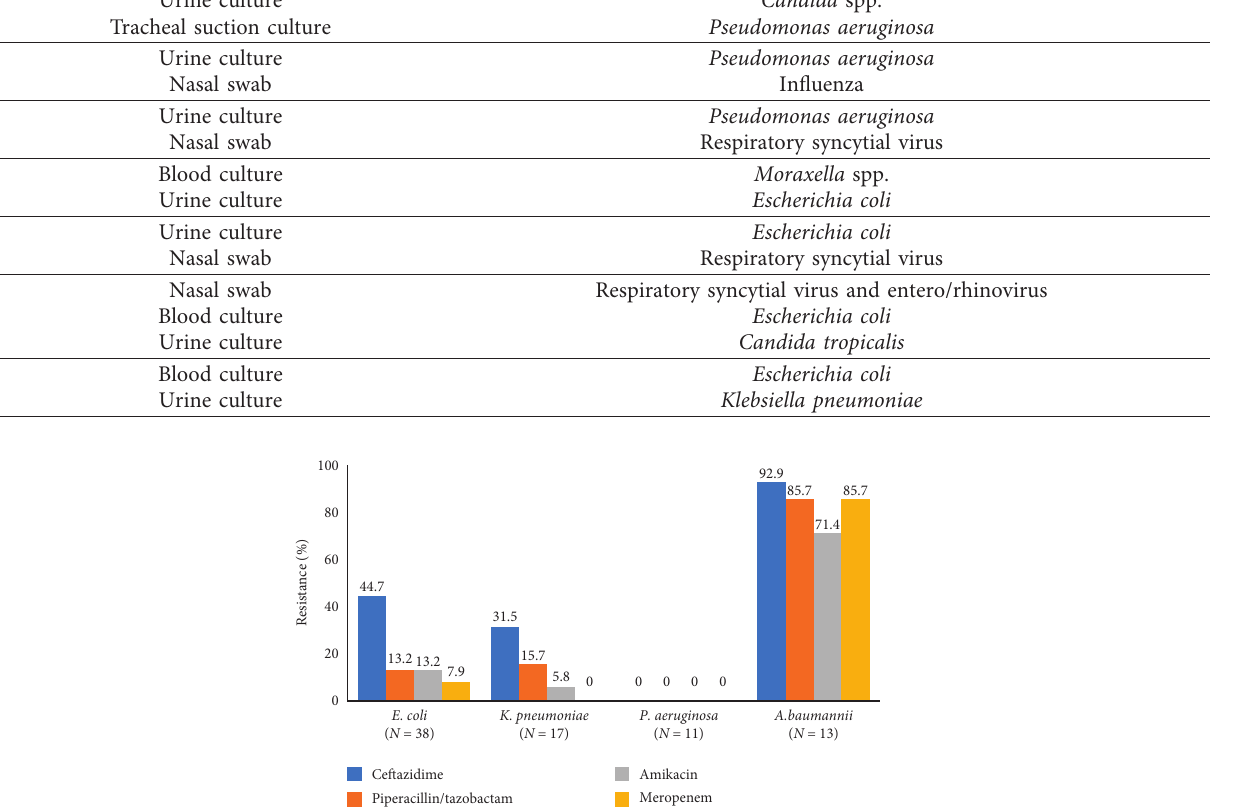
Figure 1: Percentage of antibiotic resistance of Gram-negative